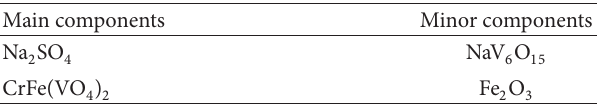
Figure 3: Optical microscopy image of superheater microstructure. Table 2: XRD results of deposits on the reheater and superheater tube surfaces.